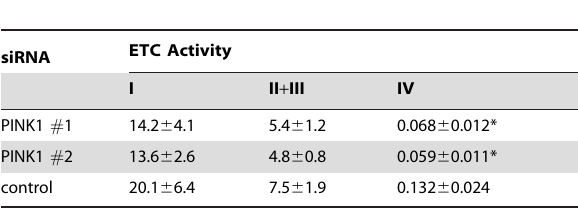
Table 1. ETC activity in SH-SY5Y cells following 12 days of PINK1